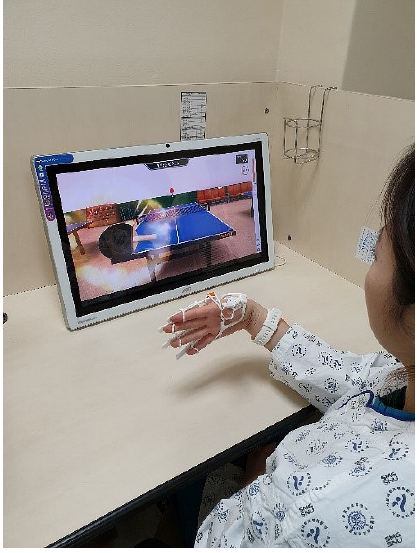
Figure A2. Illustration of the rehabilitation program using a wearable device.